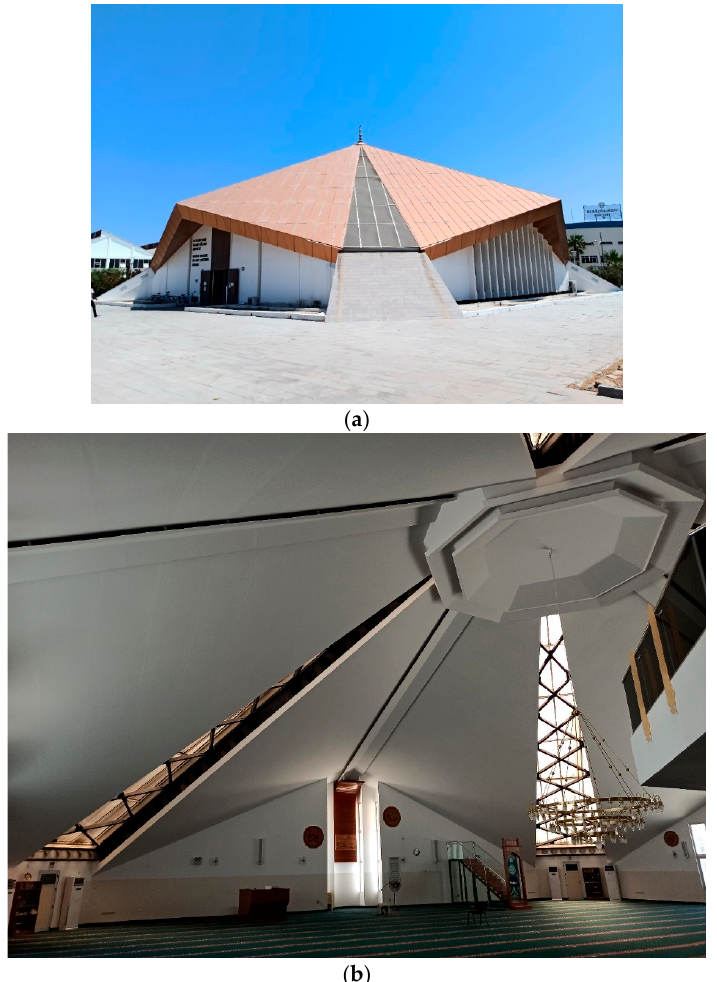
Figure 11. ( a ) Famagusta, Selim II mosque on the EMU campus, 2017, entrance and lateral facades (photo: authors). ( b ) Famagusta, Selim II mosque on the EMU campus, 2017, view onto the mihrab niche (photo: authors).